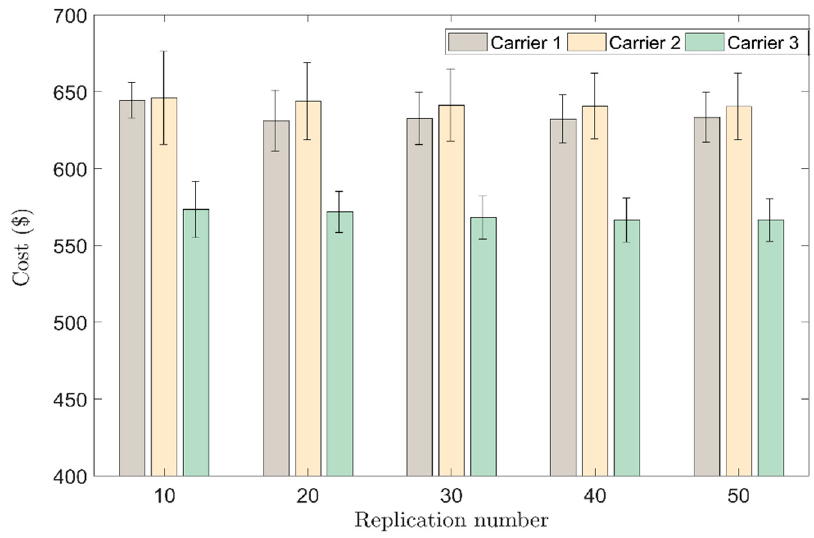
Figure 4. Cost variation with problem replications.